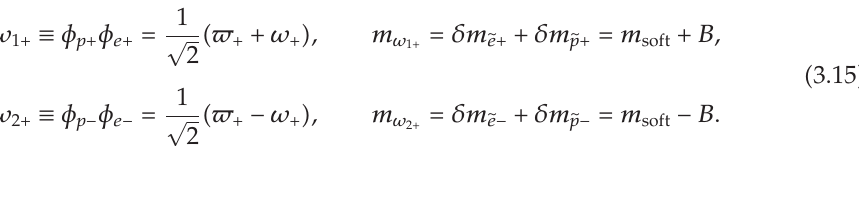
e /m p . For example, in the heavy proton limit